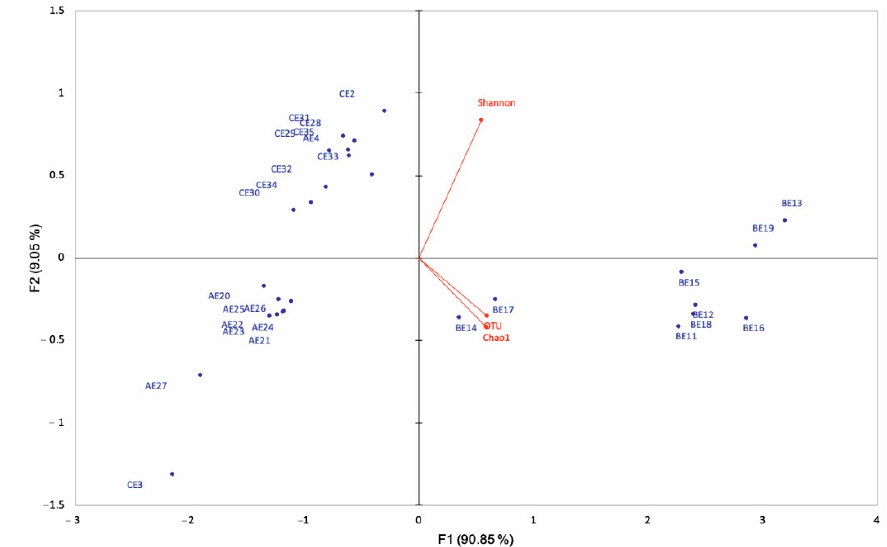
Figure 5. The PCA of the samples in the three studied springs separated according to the related OTUs and the diversity indices, Chao1 and